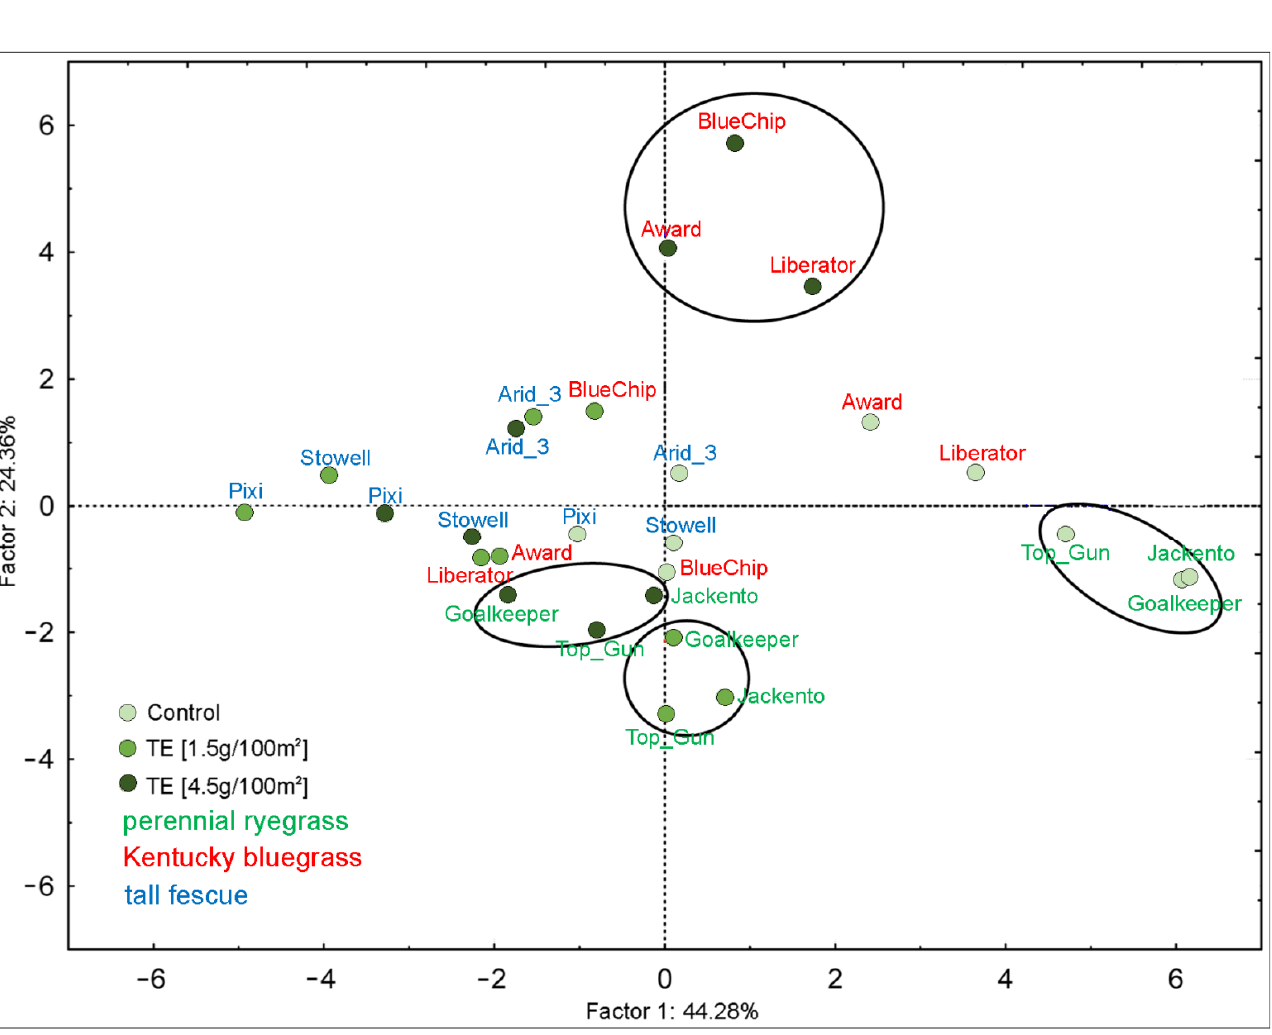
Figure 5. The distribution of tested varieties in the PCA plot is based on the data set: visual merit, turf density, turf color, chlorophyll index, and Chl a fluorescence parameters. In addition, color code is used for species: green—varieties of perennial ryegrass: Goalkeeper, Jackento, Top Gun; red—varieties of Kentucky bluegrass: Award, BlueChip, Liberator; blue—varieties of tall fescue: Arid 3, Pixi and Stowell.